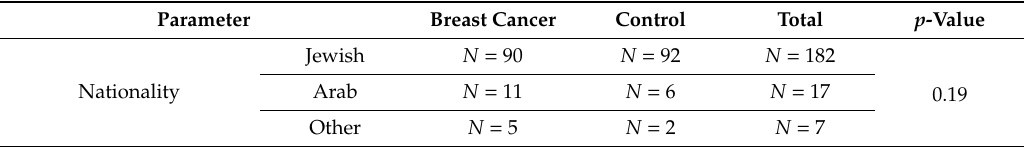
Table 1. Demographic, personal characteristics, and risk factors of women in the study and control